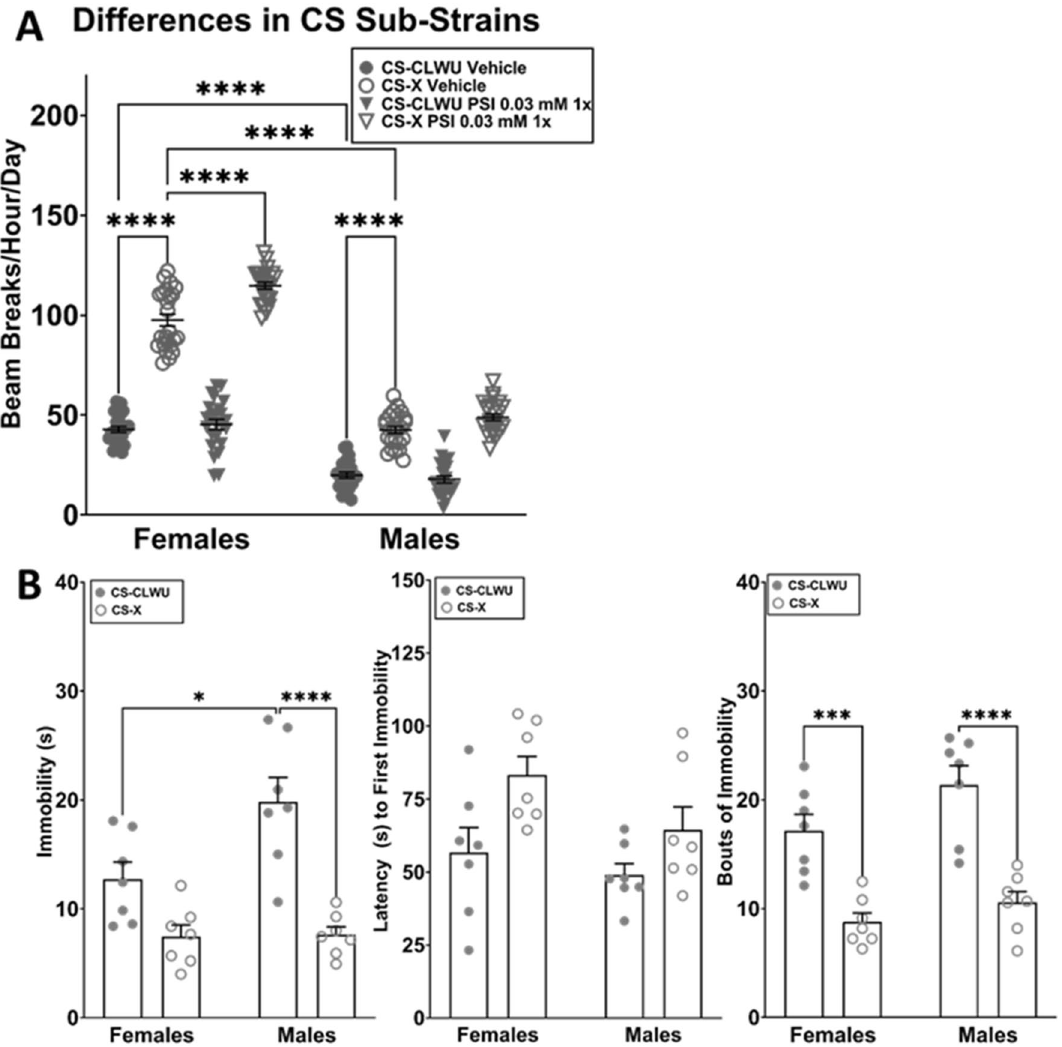
Figure 2. Differences in CS sub-strains in the DAMS and FST. The locomotor activity and forced swim responses of 6-day-old flies from two distinct CS lineages ( CS CLWU and CS X ) were compared under control and PSI (0.03 mM) 5× conditions, 5 days after administration. Data were evaluated using 2-way ANOVA; * p < 0.05, *** p < 0.001, **** p < 0.0001. ( A ) When fed vehicle medium, CS X flies of both sexes were more active than CS CLWU , and males of both strains were less active than females. PSI increased locomotor activity in female CS X flies. No other relevant differences were observed. ( B ) CS CLWU males were significantly more immobile than CS CLWU females and CS X males. CS CLWU flies had significantly more bouts of immobility than CS X . No other relevant differences were